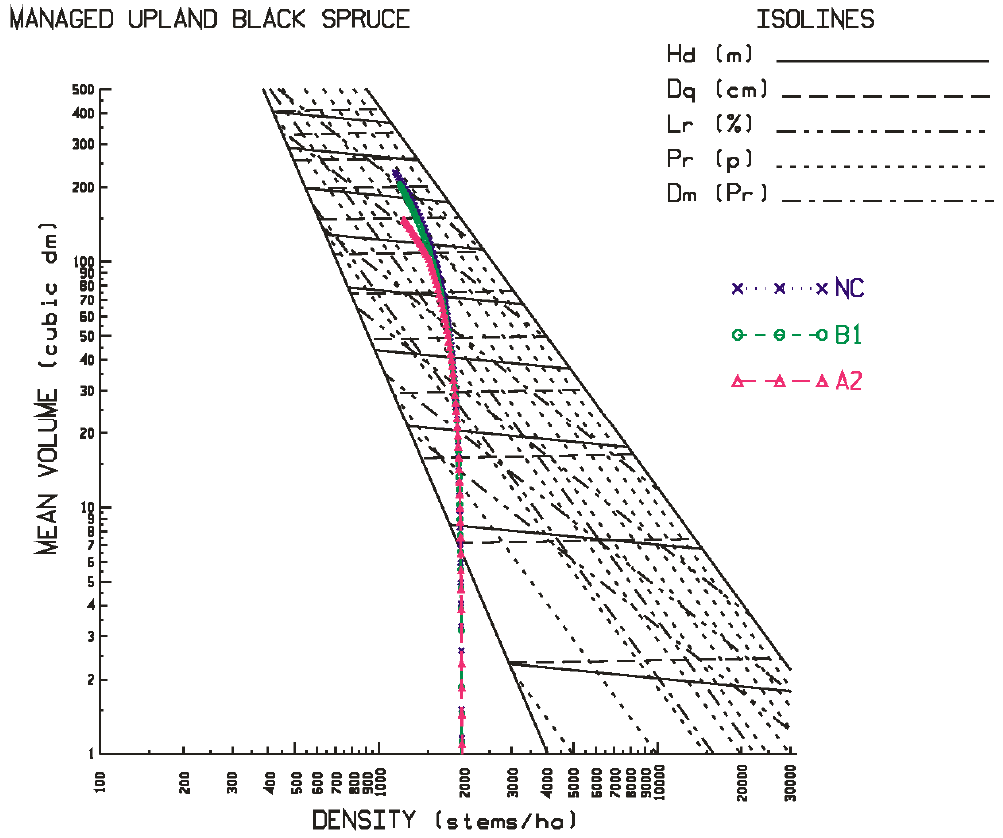
Figure 1. Temporal size-density trajectories by scenario for black spruce plantations within the context of the SSDMM graphic for poor-to-medium quality sites ( S I = 8.6) within north-eastern Ontario. Graphically illustrating: (1) isolines for mean dominant height (Hd; diagonal solid lines ranging from a minimum of 4 m at the bottom of the graphic to a maximum of 20 m at the top of the graphic separated by 2 m increments), quadratic mean diameter (Dq; horizontal long dashed lines ranging from a minimum of 4 cm at the bottom of the graphic to a maximum of 26 cm at the top of the graphic separated by 2 cm increments), mean live crown ratio (Lr; diagonal lines starting at the 35% (highest placed line) then 40% and thereafter at increasing 10% increments until 80% (lowest placed line)), and relative density index (Pr; 0.1-1.0 by 0.1 intervals (short-dashed diagonal lines)); (2) crown closure line (lower diagonal solid line) and self-thinning rule at a Pr = 1.0 (upper diagonal solid line); (3) lower and upper relative density (Pr) diagonal isolines delineating the optimal density management window (Dm; 0.32 ≤ Pr ≤ 0.45). and (4) expected 75 year size-density trajectories with 1 year intervals denoted for each emission scenario (NC, B1, and A2). Source: Modified SSDMM for black spruce.